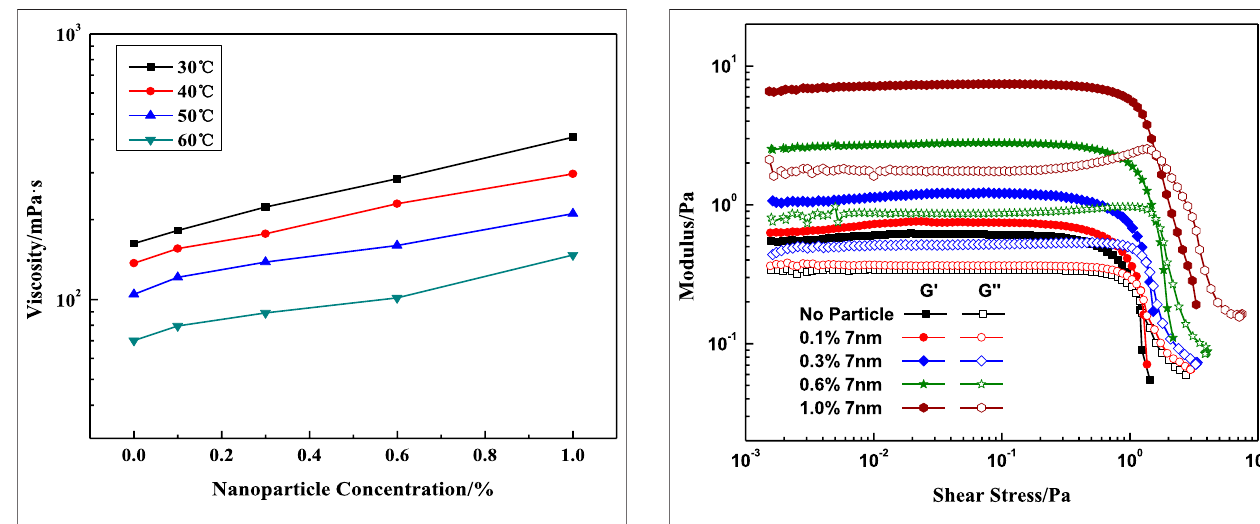
FIGURE 9 | Effect ofSiO 2 concentration on solution viscosity at different temperatures ( w (LBA + SDS) (cid:2) 0.8%, LBA:SDS (cid:2) 3:1, w (NaCl) (cid:2) 4%, γ (cid:2) 7.34s − 1 ).